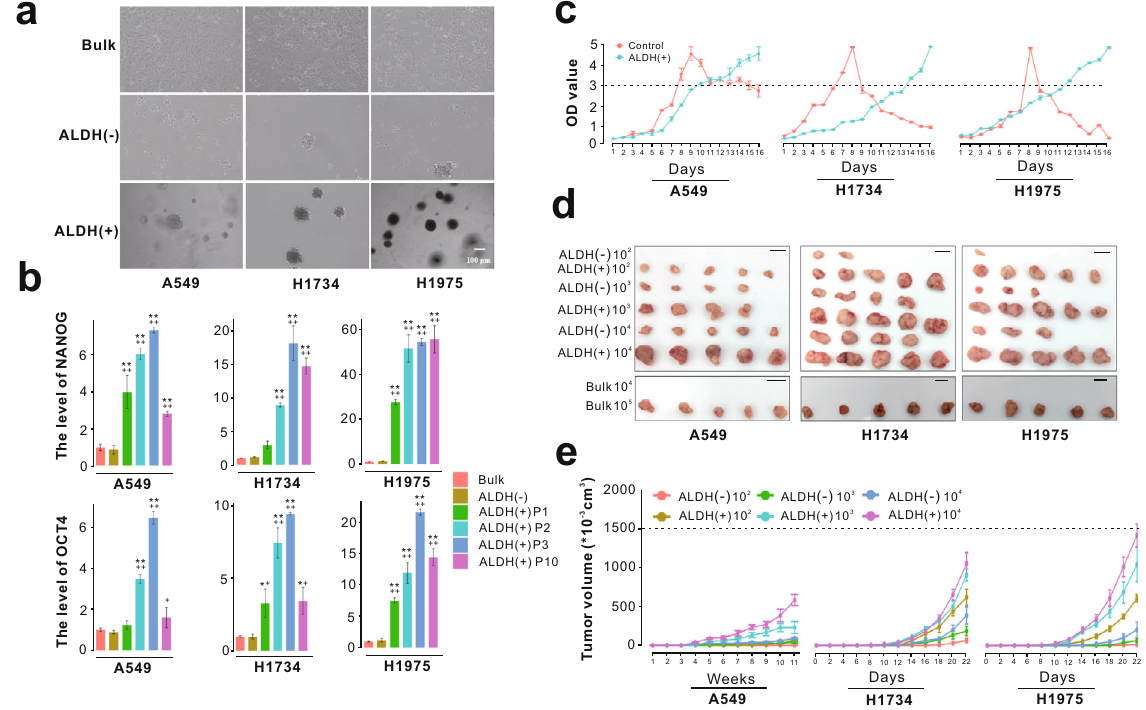
Fig. 1 The ALDEFLUOR-positive cells from human lung adenocarcinoma have cancer stem-like cell properties. a The bulk cells, ALDEFLUOR-negative cells, and ALDEFLUOR-positive cells from three lung adenocarcinoma cell lines were cultured with serum-free suspension 3D culture system for 7 days. b The levels of stem genes (NANOG and OCT4) of bulk cells, ALDEFLUOR-negative cells, and ALDEFLUOR-positive cells with different passage from three cell lines were analyzed by qPCR. ** p < 0.01, * p < 0.05, when compared with bulk cells. ++ p < 0.01, + p < 0.05, when compared with ALDEFLUOR-negative cells. c The cell growth rates were determined by CCK-8 assay. The bulk cell population was used as control. d In vivo mice tumor development was evaluated after subcutaneous injection of different number of ALDEFLUOR-negative and ALDEFLUOR-positive cells. ALDEFLUOR-positive cells were injected to the right side of mice while the same number of ALDEFLUOR-negative cells were injected to the left side of the same mice. Experiments were performed in quintuplicate. Scale bar, 1 cm. e The volume of solid subcutaneous tumor changed over time (error bars represent